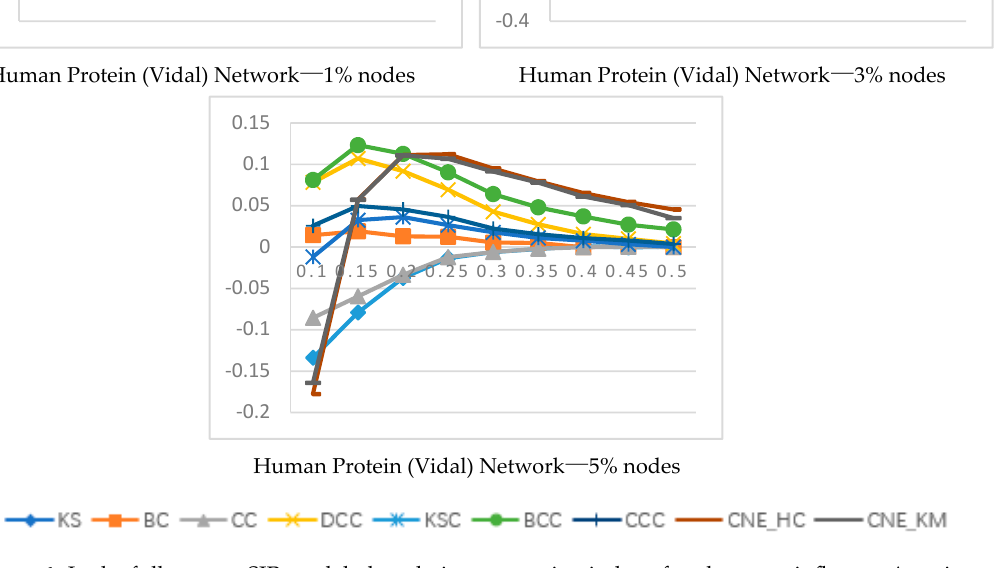
Figure 4. In the full-contact SIR model, the relative proportion index of node group influence ∆ varies with the infection rate β . From left to right corresponds to taking 1%, 3% and 5% of the number of nodes in the dataset as the number of nodes in the key node group respectively.